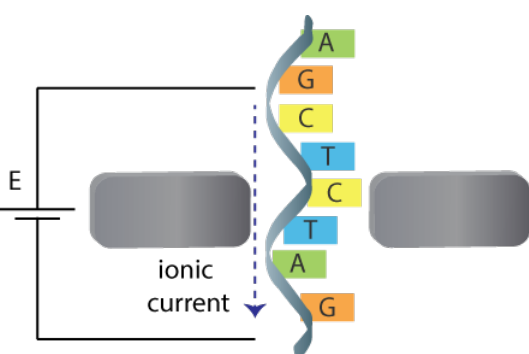
Figure 6. Schematics showing the spatially-resolved translocation of a DNA molecule through a nanopore for sequencing applications.